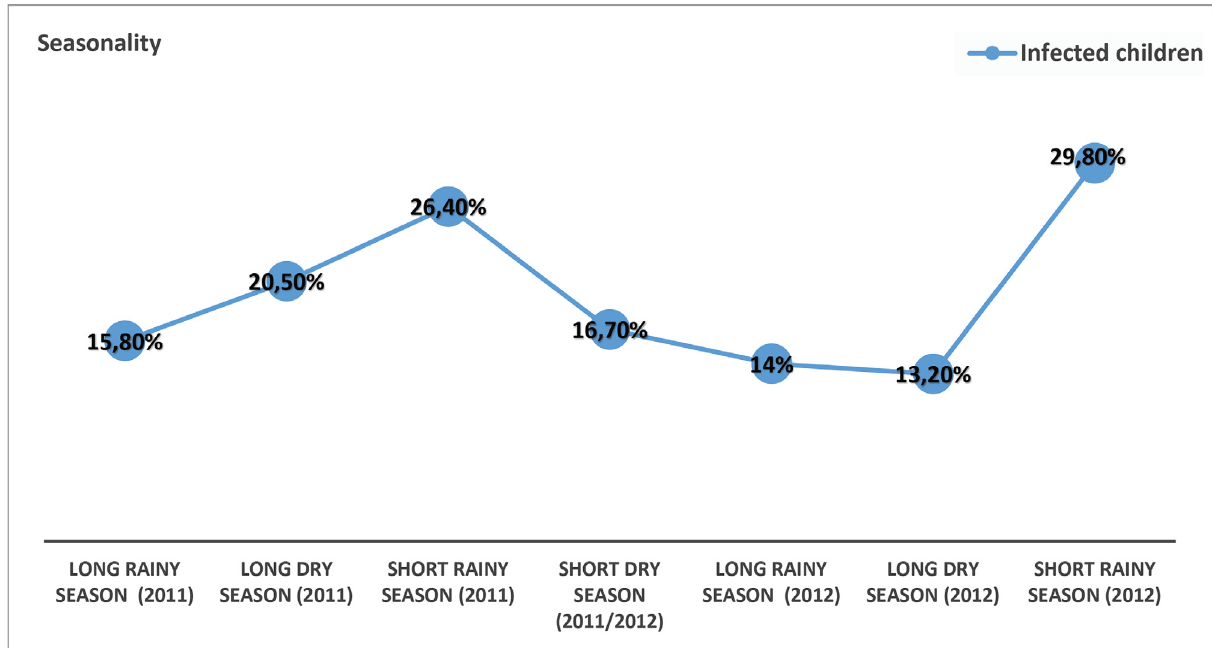
Figure 2. Temporal distribution of plasmodial